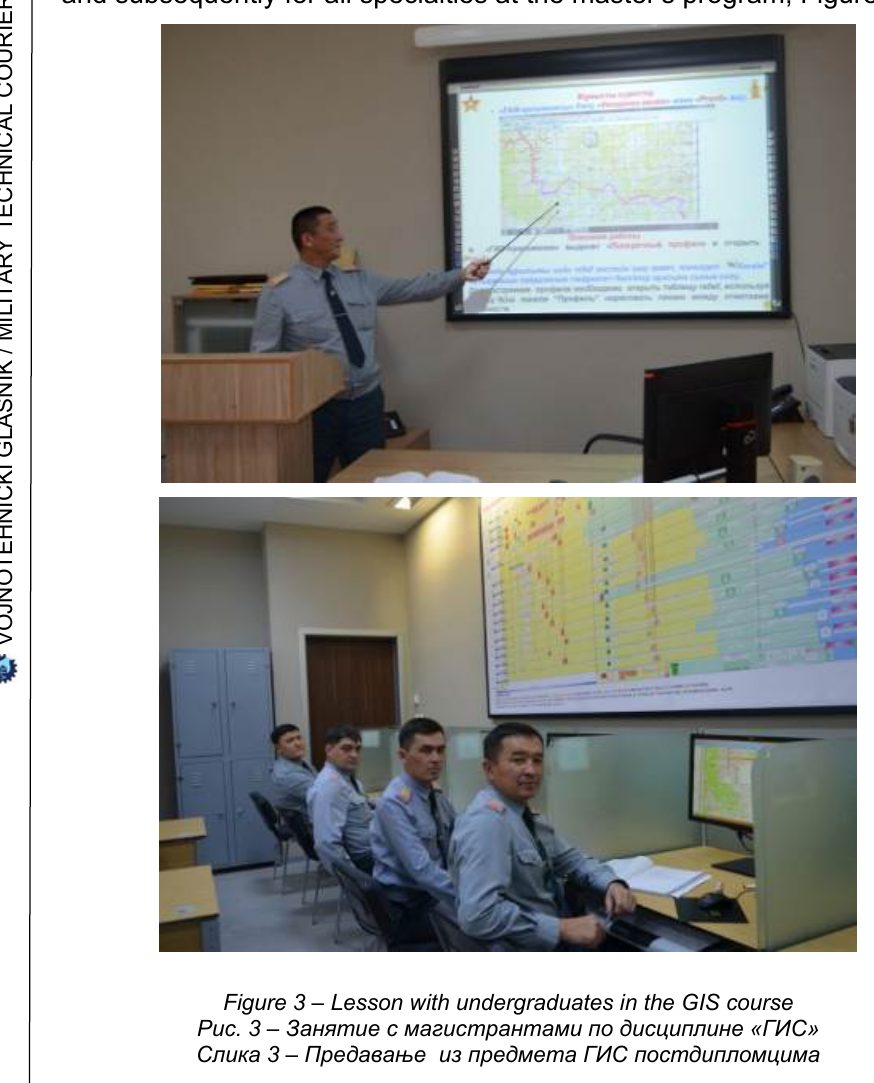
Рис . 3 – Занятие с магистрантами по дисциплине « ГИС